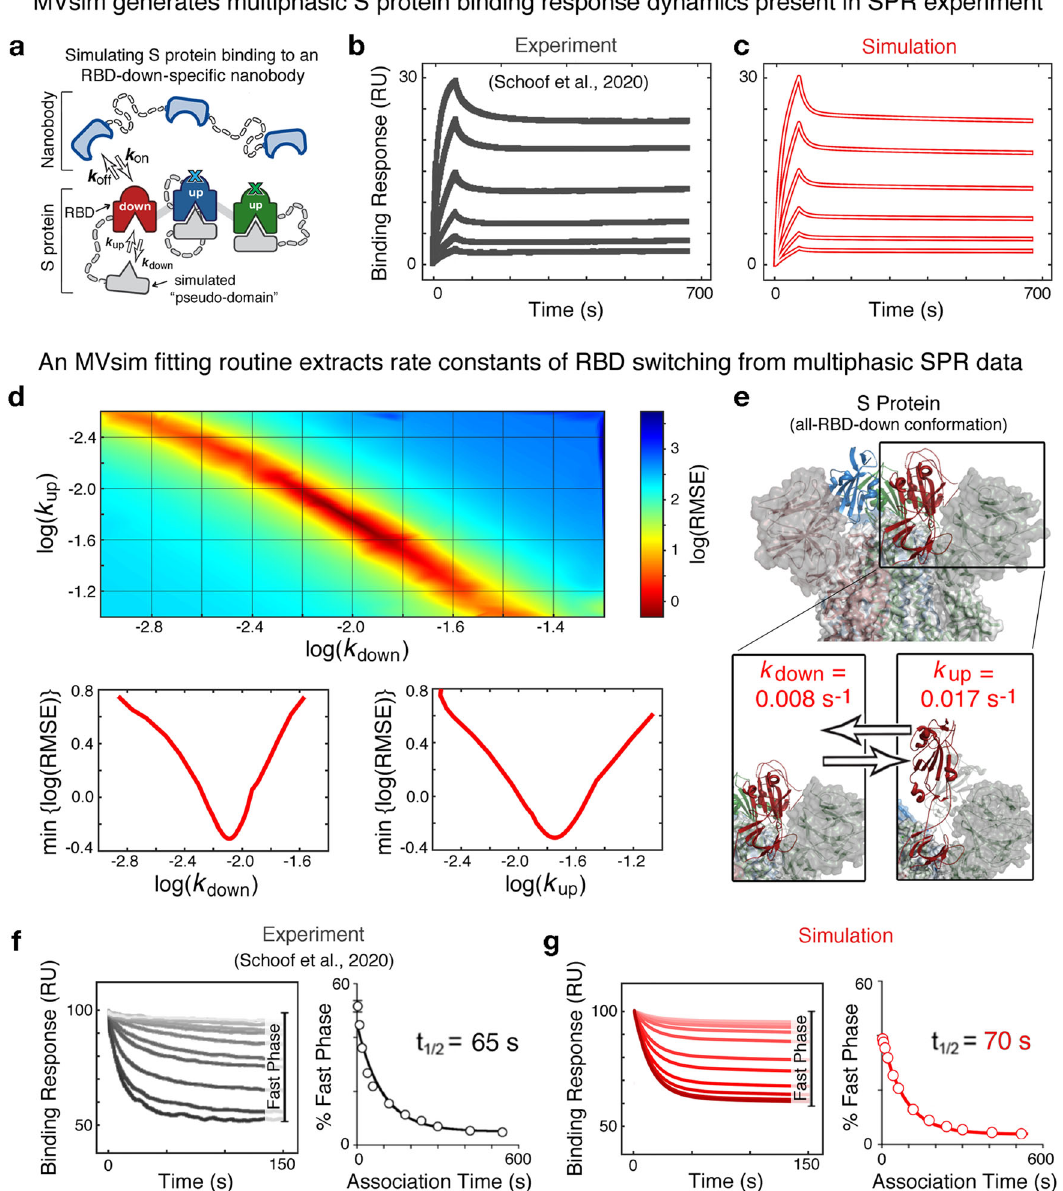
k fi t para- up ( d , top panel) converges on a unique solution for a single set of best- meter valuesfor k down ( d , bottom left panel)and k up ( d , bottom right panel)for an individual RBD ( e ). f Conformational switching half-life experiments also adapted from ref. 37, alter the relative proportion of “ slow phase ” inhibitor dissociation events (i.e., high-avidity bivalent and trivalent interactions) and “ fast phase ” inhi- bitordissociationevents(i.e.,monovalentinteractions).Here,duetorelativelyslow RBDswitchingrates,longerassociationtimesenablemoreSproteintobeboundin high-avidity interactions, and thus give rise to small percentages of “ fast phase ” dissociationevents. g Toassess MVsim accuracy,the fi ttedparametersareusedina modeling framework to simulate the experimental system and compare half-lives ( t 1/2 ) of “ RBD-up ” S protein conformations. The input parameters for these simu- lations are given in the MVsim user tutorial in the Supplementary